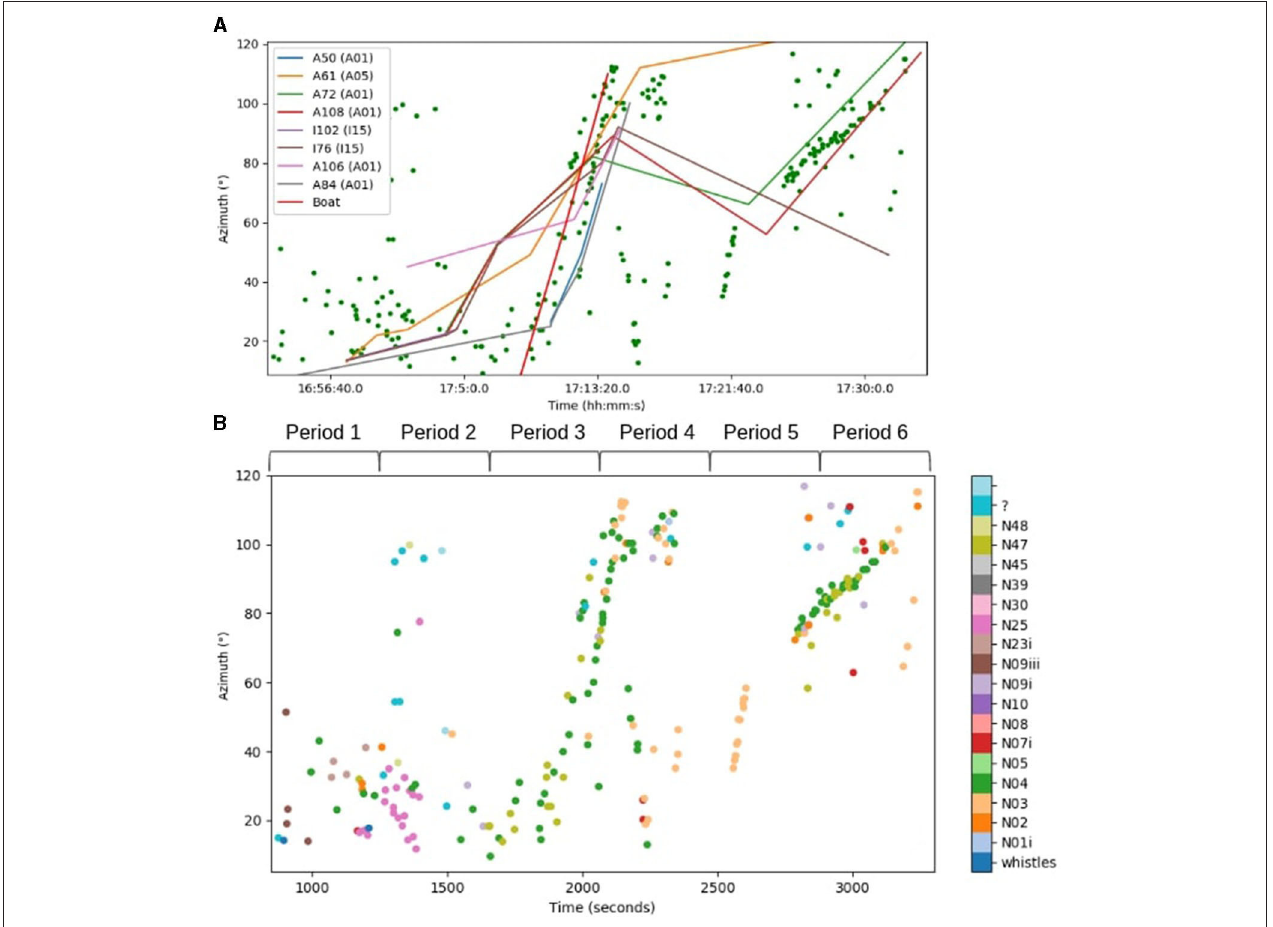
FIGURE 5 | (A) Graph of the passage of the 11th of August. Each green point represents a vocalization placed in azimuth. The different curves are the positions of each individual visually detected. The red line is the visual trajectory of the boat. (B) Graph of the passage of the 11th of August. Each point represents a vocalization placed in azimuth. Each color represents a type of call. The most common types are N04, N03, and